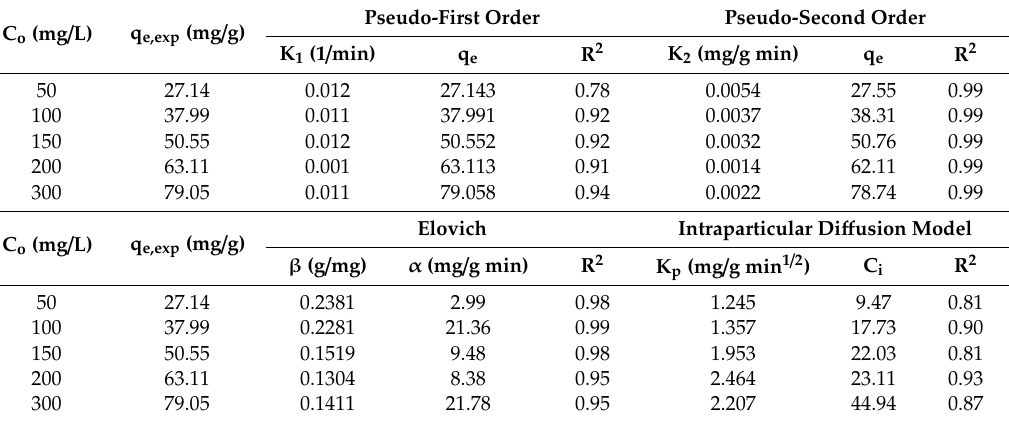
Table 3. Kinetic parameters of the models studied for 2,4-D on MAC at di ff erent initial concentrations and 25 ◦